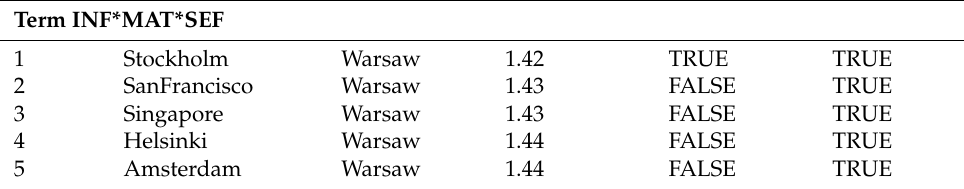
Table 12. Comparison of a typical case with a deviant case consistency (OVE).